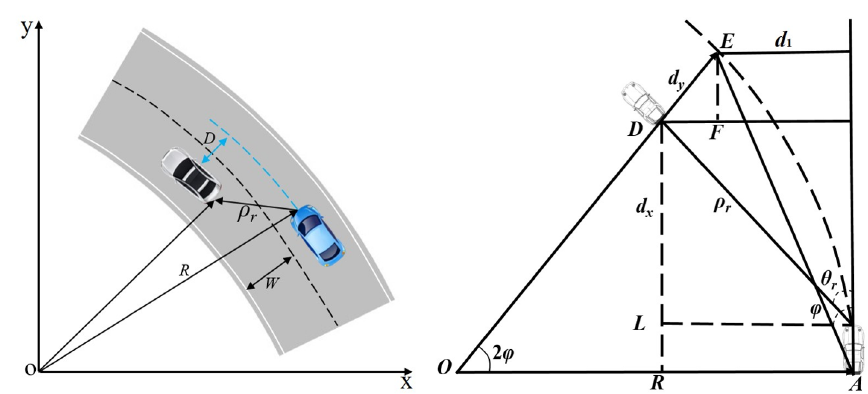
Figure 3. Longitudinal following on curved roads.